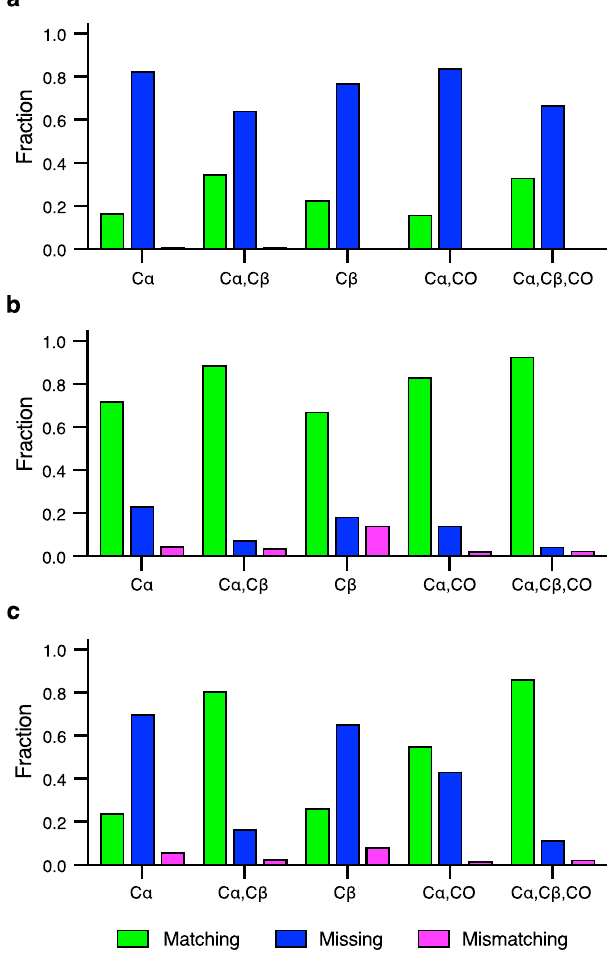
triple resonance experimental foundation and chemical shift prediction pre- cision. The resonance assignment by BARASA using the indicated cross cross- peak types from the triple resonance spectra and, residue-type (BMRB) chemical shift statistics ( a ) or chemical shifts predicted by SHIFTX+based on a structural model provided by AlphaFold2 ( b ). Triple resonance data sets include the peaks from the following spectra: HNCA/HN(CO)CA (C α ), HN(CA) CB/HN(COCA)CB (C β ) and HNCO/HN(CA)CO (CO). Bar heights indicate the fractions of residues that are accurately matched (green), mismatched (magenta) or missing (i.e., unassigned) (blue) to the reference assignments. Equivalent runs with FLYA ( c ) using the data set of ( b ) reinforce the conclusion that BARASA is more robust to non-ideal data. Source data are provided as a Source Data fi